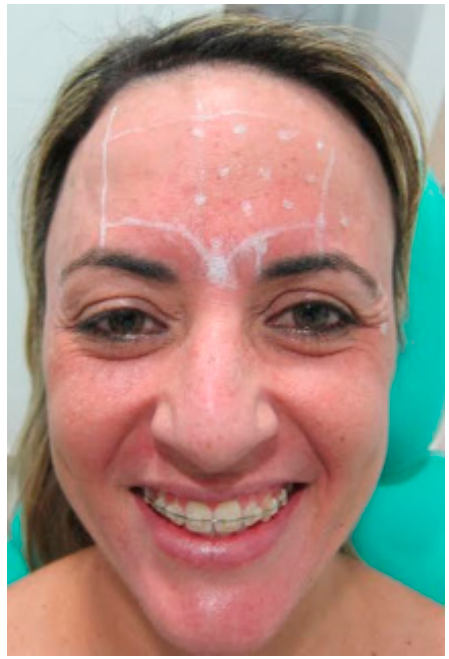
Figure 5. At 2-week follow-up, the patient was noted to have correction of complex facial muscle function and symmetrical appearance of the frontal area with frontal muscle contraction (Figures 6 and 7).